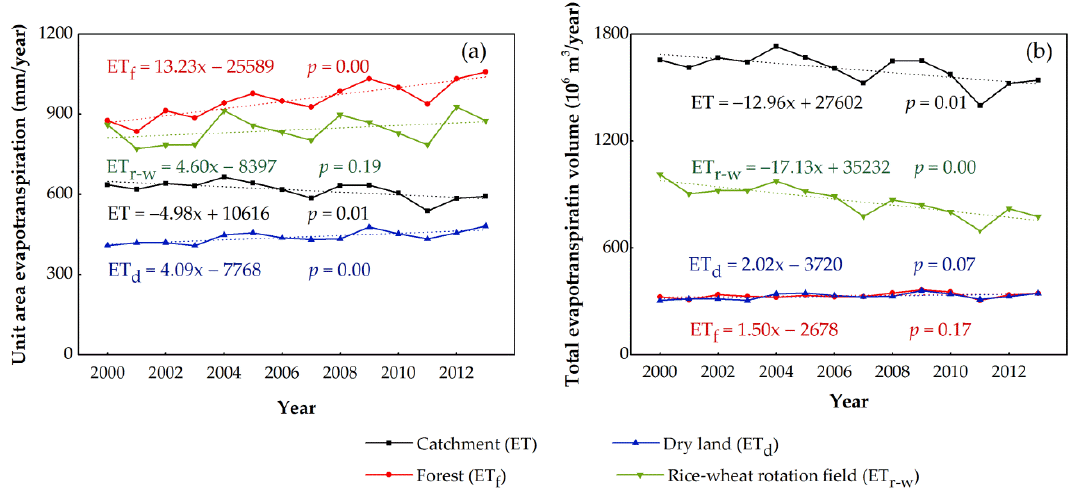
Figure 9. A comparison of the temporal trends from 2000 to 2013 for the Qinhuai River Basin: ( a ) mean annual evapotranspiration at the pixel scale; and ( b ) total evapotranspiration volume by land use types.